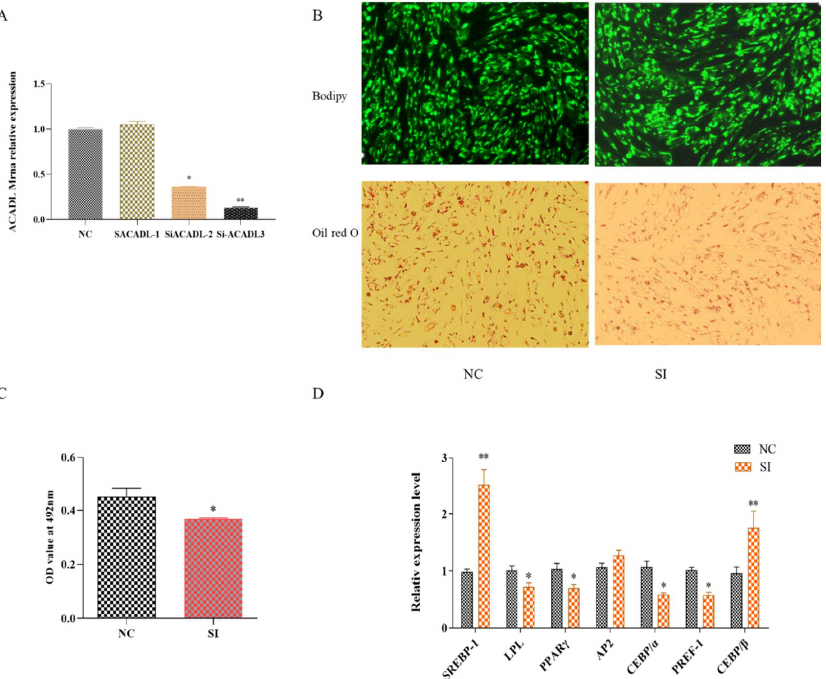
Figure 2. The effect of ACADL interference on goat adipocyte differentiation. ( A ) Expression efficiency detection after ACADL interference. ( B ) Morphology observation of Oil red O staining. ( C ) Oil red O staining showed the OD value at 492 nm during the differentiation of intramuscular adipocytes. ( D ) Effect of goat ACADL overexpression on adipocytes related gene’s expression. “*” significant difference and “**” very significant difference.